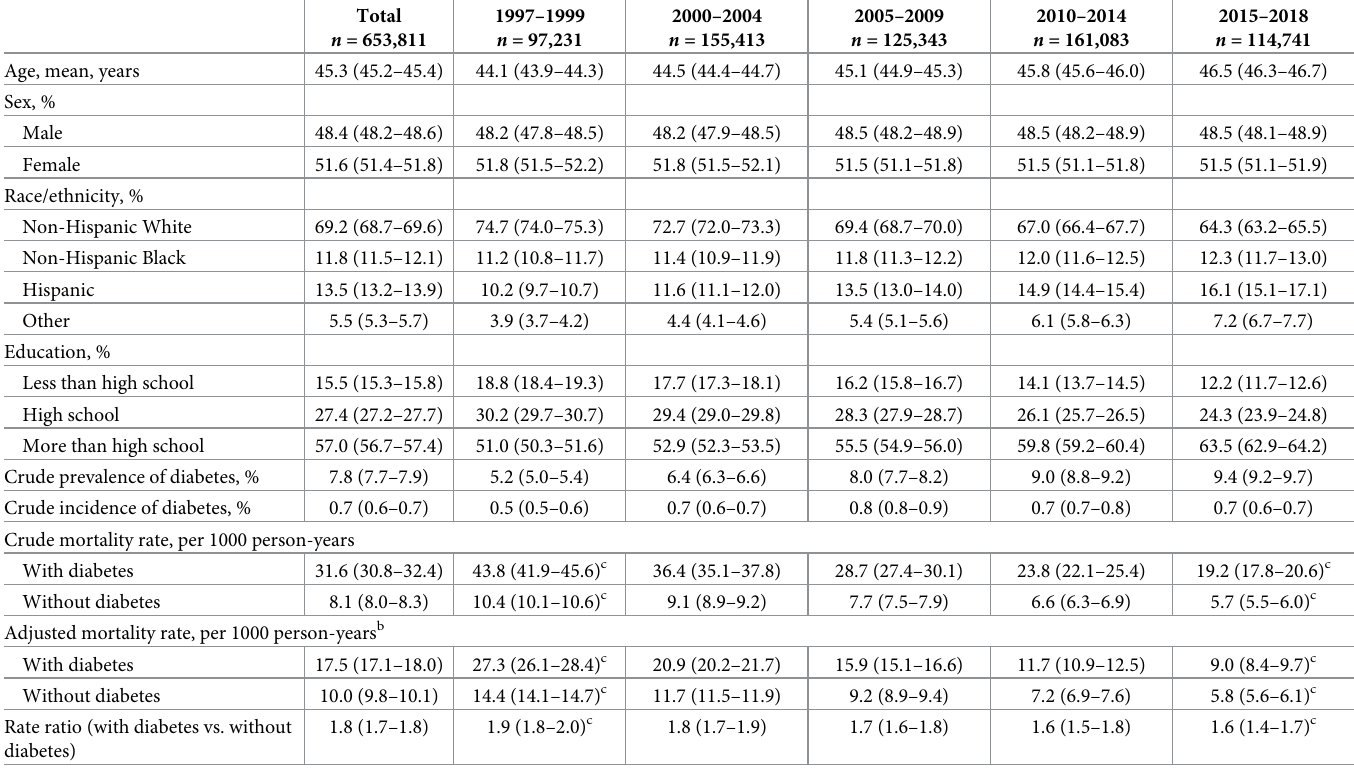
Table 1. Participant characteristics, prevalence and incidence of diagnosed diabetes, and mortality among aged 18 years and over a